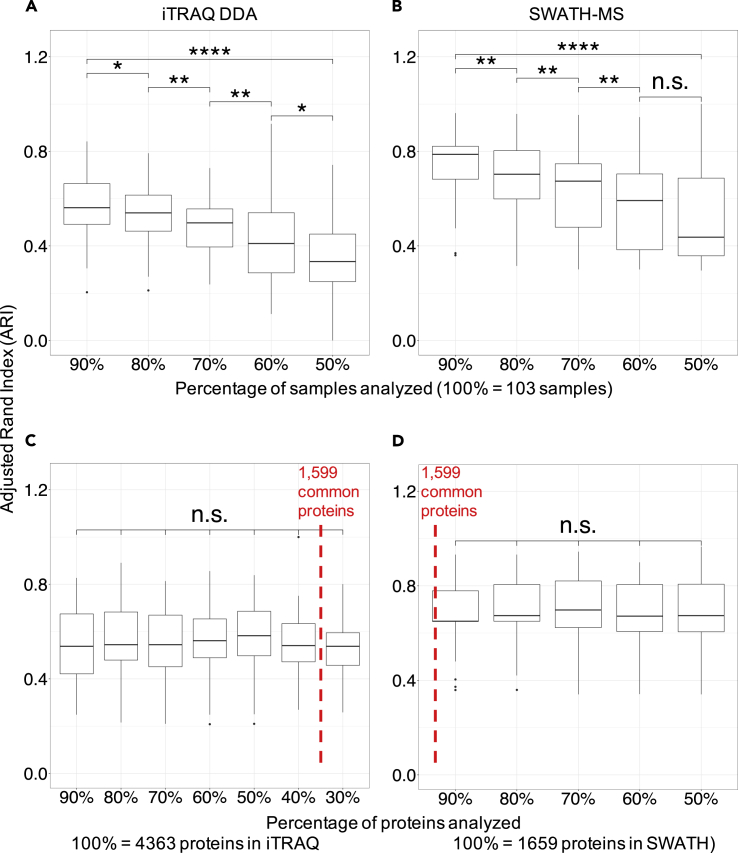
Proteomic Cluster Stability as a Function of Sample Number and Protein Number in the iTRAQ DDA and SWATH-MS DatasetsCluster stability measured by the Adjusted Rand Index (ARI) as a function of the percentage of tumors analyzed in the iTRAQ DDA (A) and SWATH-MS (B) datasets. (C and D) Cluster stability assessed by ARI as a function of the percentage of quantified proteins in the iTRAQ DDA (C) and SWATH-MS (D) datasets. ∗p < 0.05, ∗∗p < 0.01, ∗∗∗∗p < 0.0001. n.s. non-significant